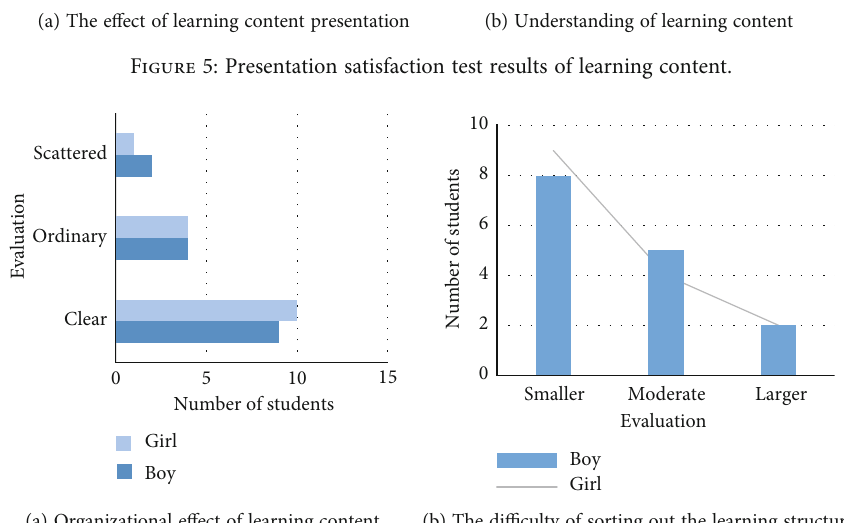
Figure 6: Organizational satisfaction test results for learning content.